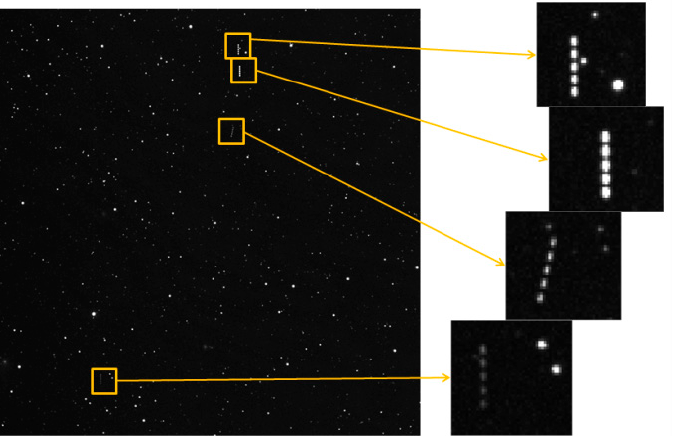
Figure 5. Image after maximum projection (Take five frame images projection as an example.).